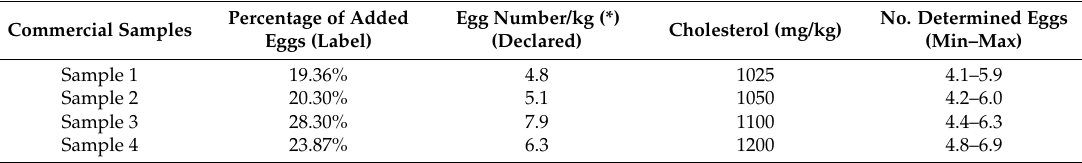
Table 1. Comparison of number of eggs declared on the label and number of eggs experimentally by the determination of cholesterol.